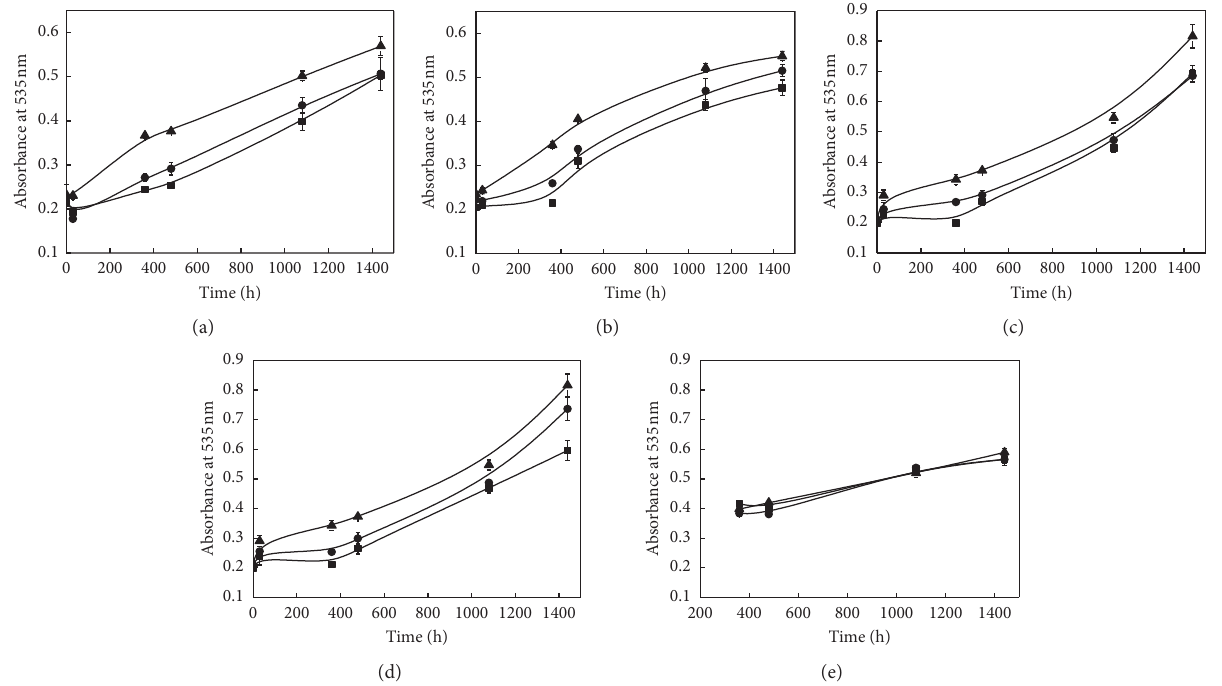
Figure 6: Variation in the absorbance of piperine derivatives in AAPH-induced oxidative damage in DNA over time. 0 μ M ( ▲ ); 80 μ M ( ● ); 160 μ M ( ■ ). (a) 5a . (b) 5b . (c) 5c . (d) 5d . (e) Piperine.